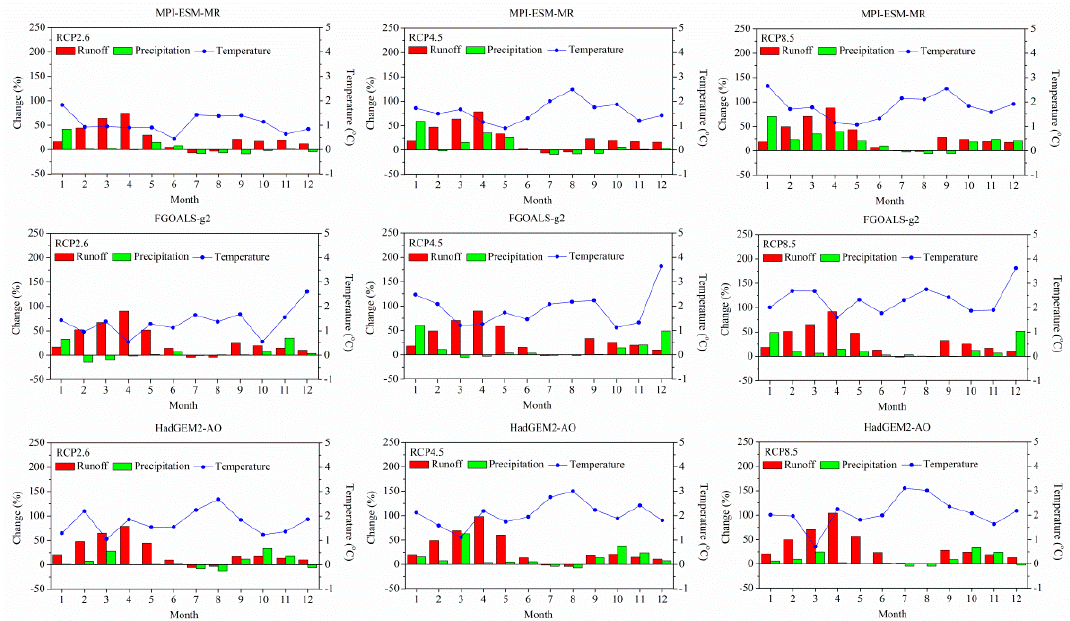
Figure 9. Comparison of average monthly runoff, precipitation, and temperature